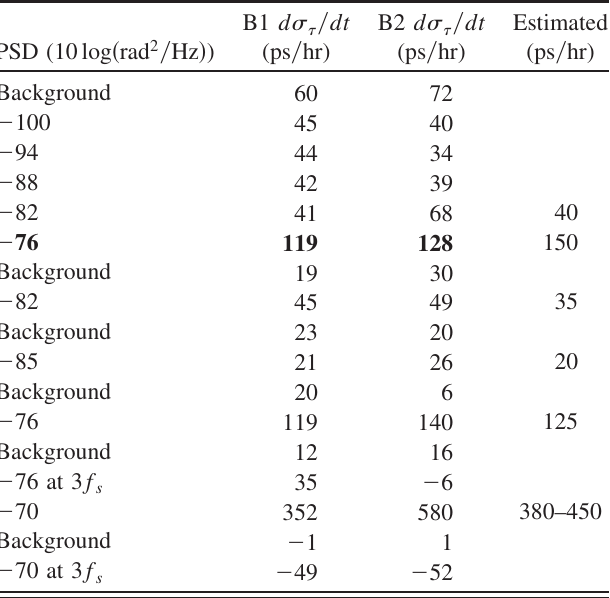
TABLE III. Bunch length growth as a function of the power spectral density (PSD) of the injected noise—referred to a single sideband